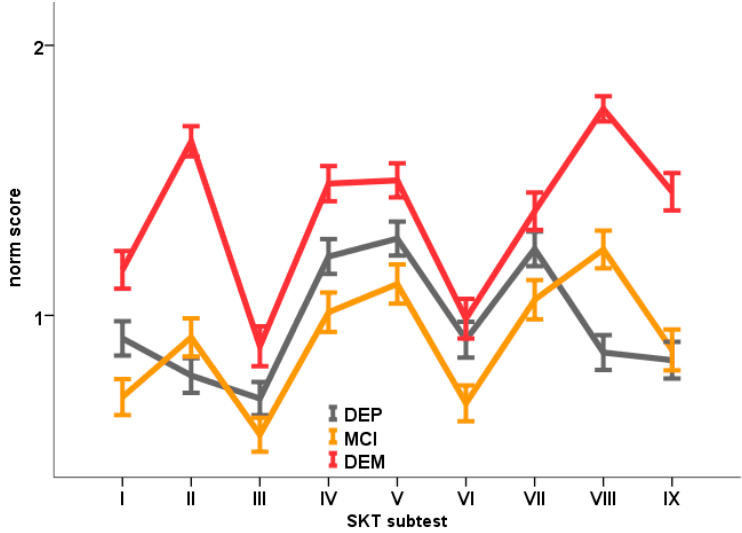
Figure 2. Norm scores (means) of the three study groups for the nine SKT subtests (I: naming objects, II: immediate recall, III: naming numerals, IV: arranging blocks, V: replacing blocks, VI: counting symbols, VII: reversal naming, VIII: delayed recall, IX: recognition memory).